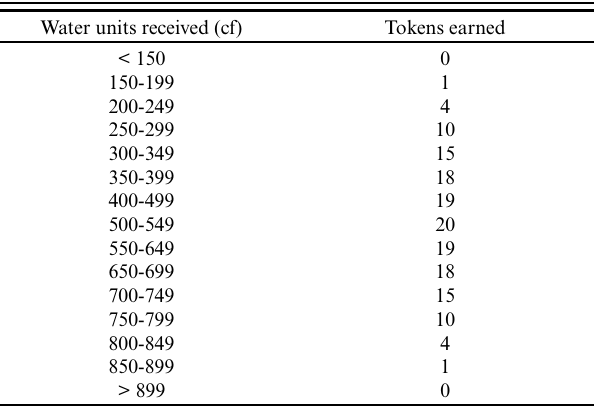
Table 3 . Earnings resulting from amount of water applied to the